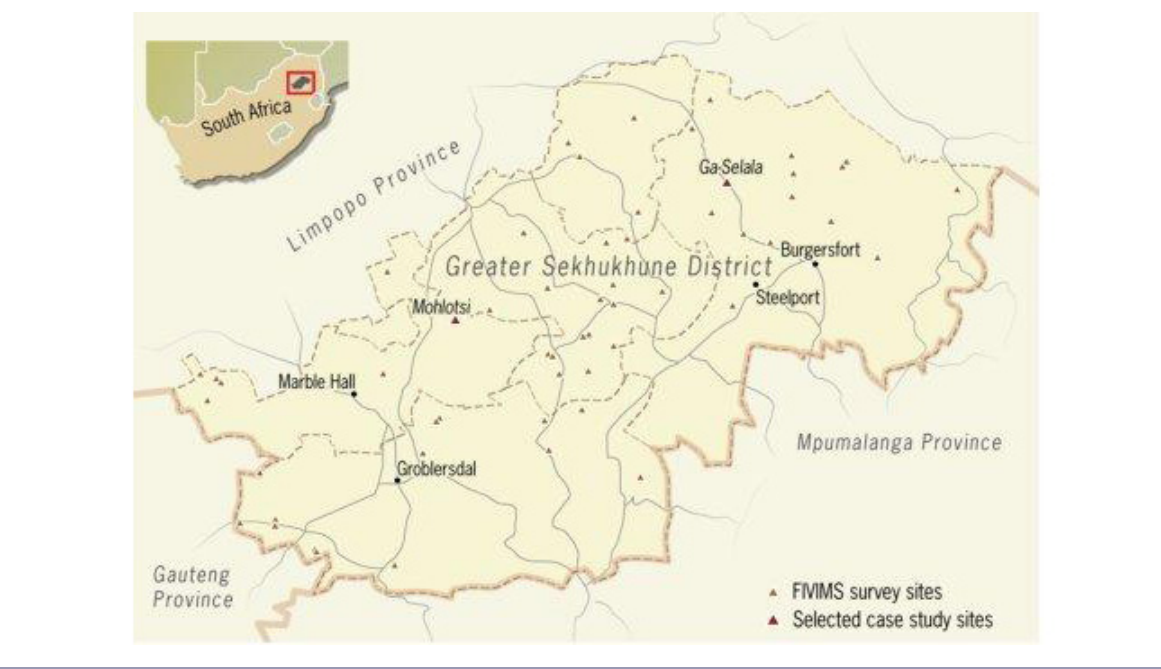
Fig. 2. Map showing Sekhukhune District and the location of the two study villages (Source: UNEP/